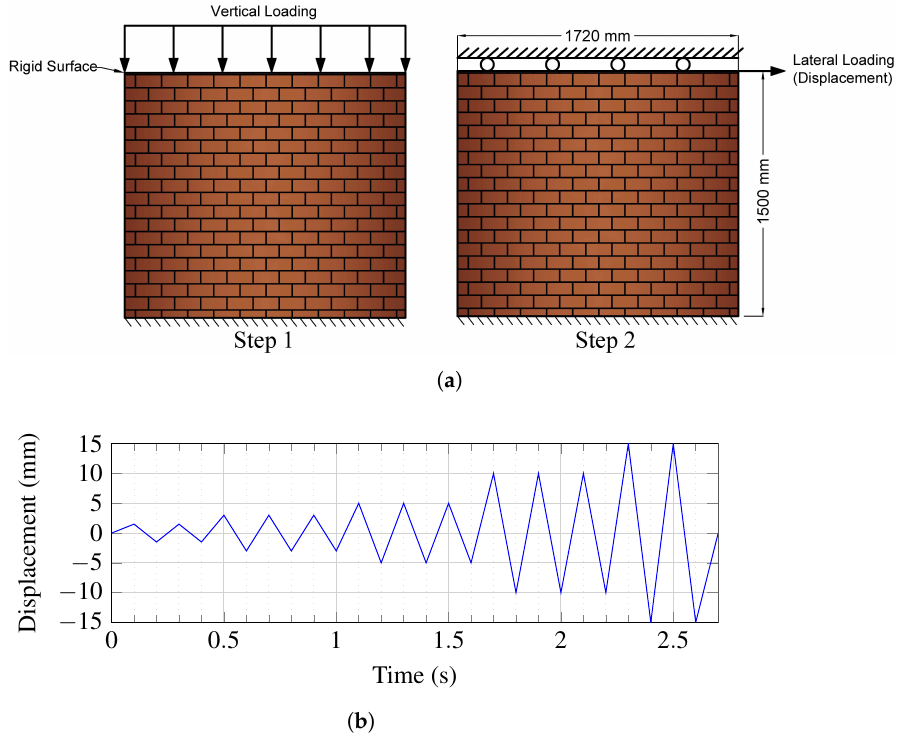
Figure 1. ( a ) Schematic of applying the vertical and horizontal loading and displacement; ( b ) the amplitude of applied lateral